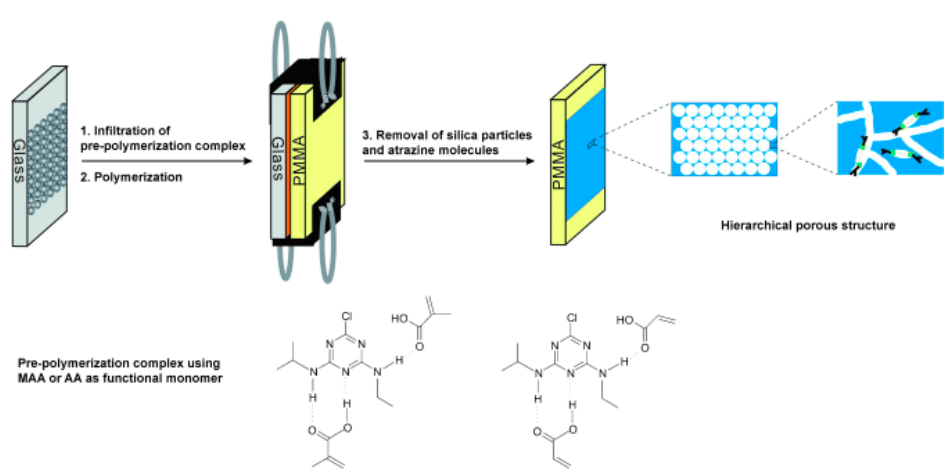
Figure 10. Schematic illustration of the procedure used for the preparation of the molecularly imprinted photonic polymer. Reproduced with permission from [32].